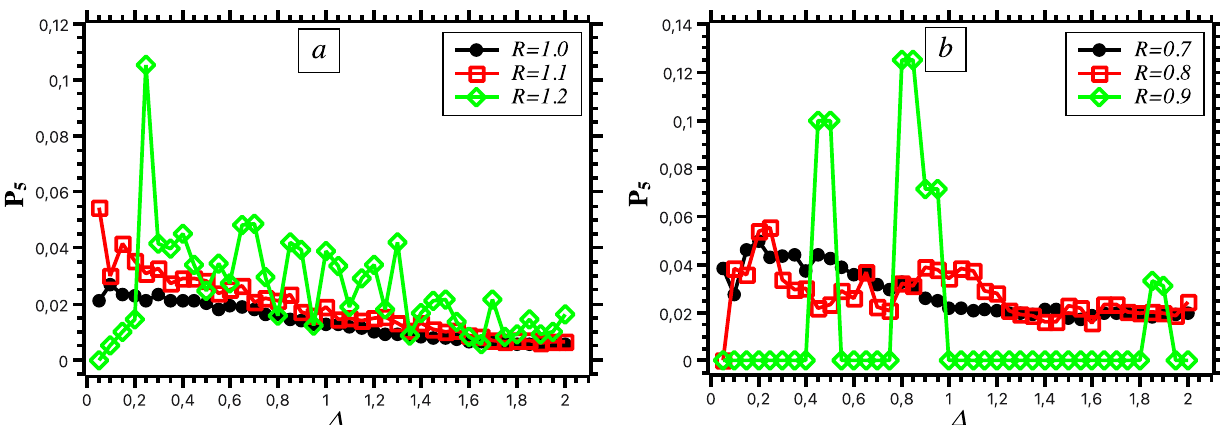
Fig. 5 The degree of alignment P 5 for the five points as a function of the disbalance Δ at the the threshold R close to to the maximum possible value for a square with R max = 1 . 414 ( a ) and for an ellipse with the large enough eccentricity e = 0 . 5 and with R max = 1 ( b